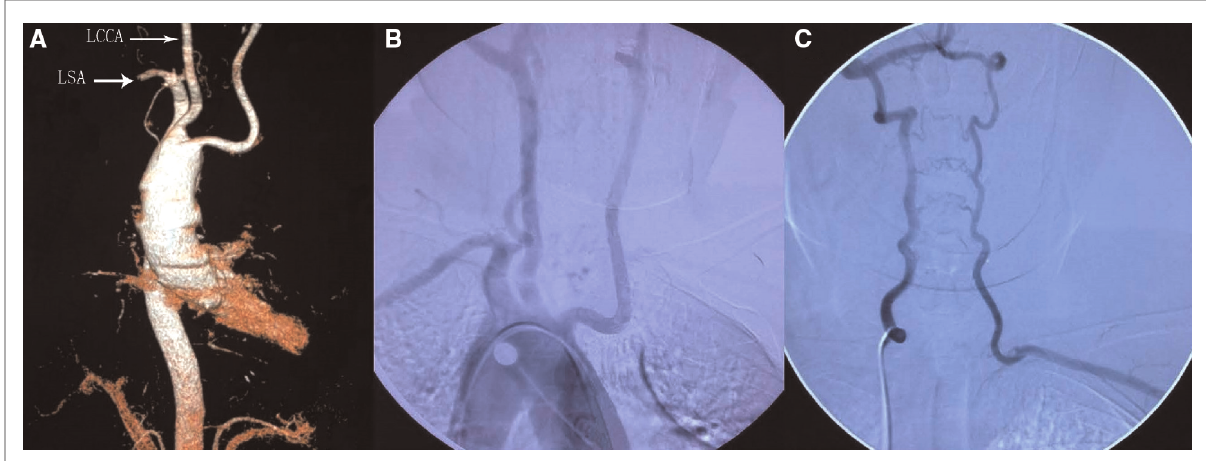
FIGURE 1 Preoperative CTA of the aorta showed a right-sided aortic arch with an abnormal great branch ( A ). Aortic DSA showed that the left subclavian artery was not visible ( B ). Left subclavian artery supplied by the left vertebral artery ( C ). LSA, left subclavian artery; LCCA, left common carotid artery.